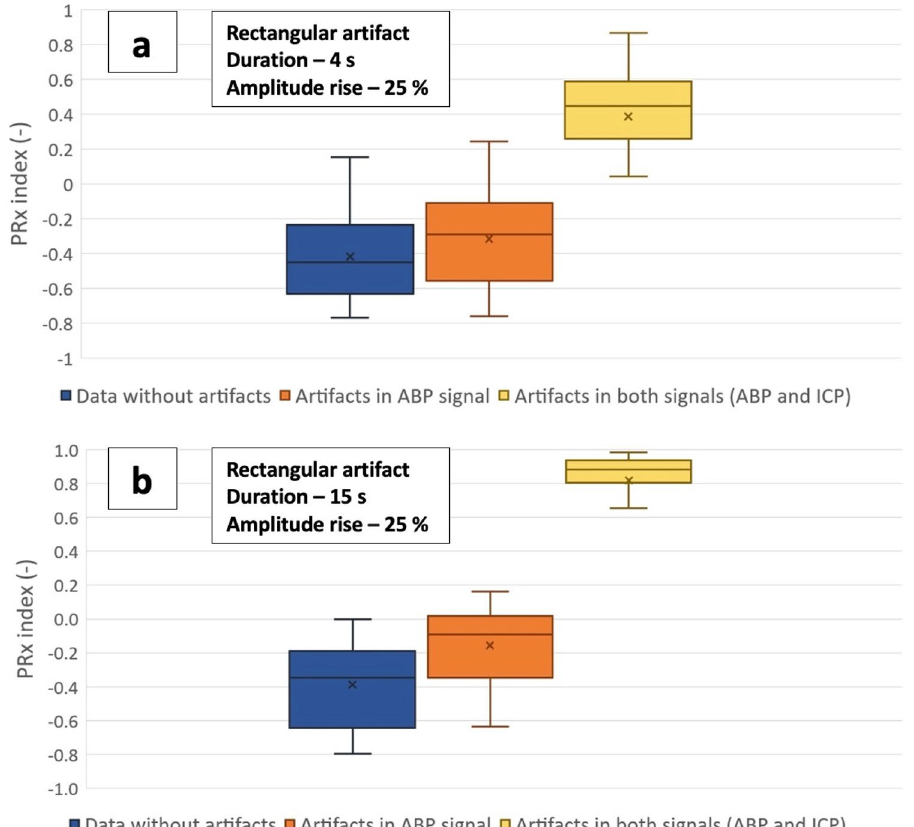
Figure 2. The effect of the rectangular artifact on PRx value. Even the shortest artifact of this shape present in both signals causes a significant change in the PRx index; when the artifact is prolonged to 15 s, the PRx index approaches 1.0. Box-and-whisker plots representing the median value, with 50% of all data falling within the box (interquartile range). The "whiskers’’ extend to the minimum and maximum. Cross inside the box represents the mean value. ( a ) Box plots depicting the effect of rectangular artifacts lasting 4 s with an amplitude rise of 25% in the arterial blood pressure waveform and in both waveforms. ( b ) Box plots depicting the effect of rectangular artifacts lasting 15 s with an amplitude rise of 25% in the arterial blood pressure waveform and in both